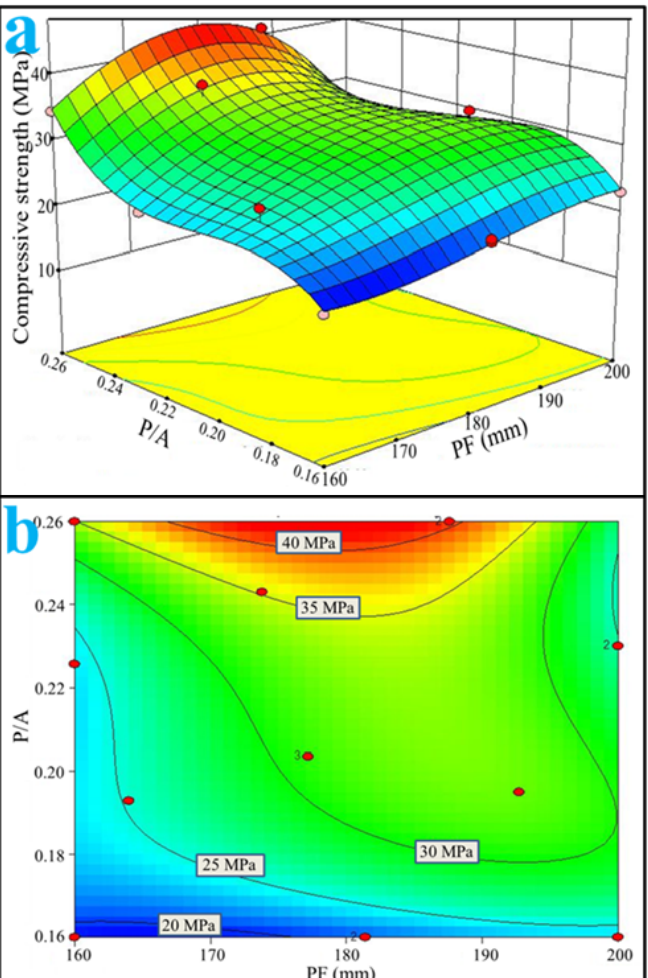
Figure 4. ( a ) Response surface and ( b ) contour line of 28-day compressive strength versus PF and P/A ratio.